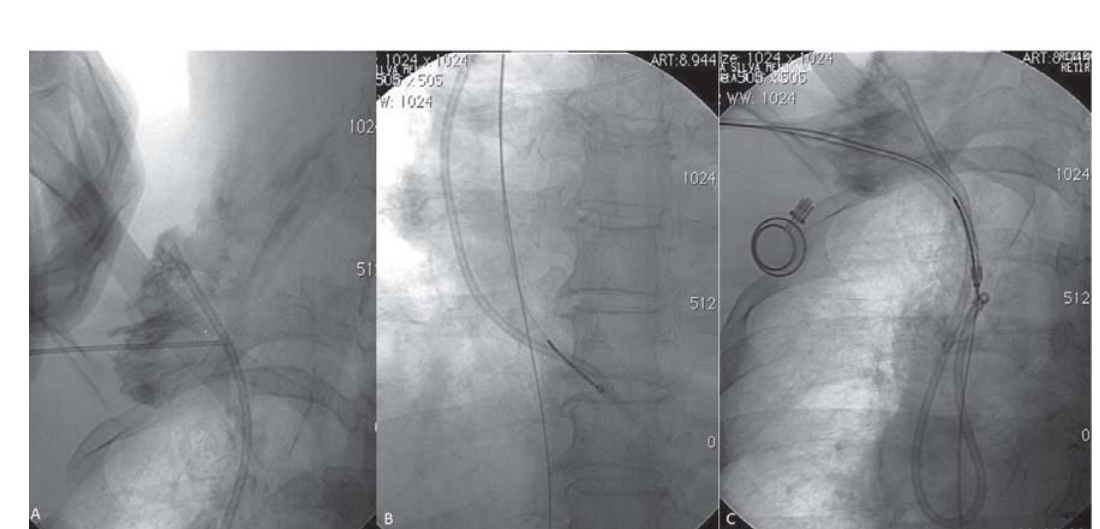
Fig. 2 – A: Punção da veia subclávia direita. B: Captura da extremidade distal do cateter com laço. Fio-guia hidrofílico paralelo ao laço com a sua extremidade distal localizada na veia cava inferior. C:– Retirada de todo o conjunto, mantendo-se o fio-guia hidrofílico na veia cava inferior (manutenção do acesso venoso subclávio)